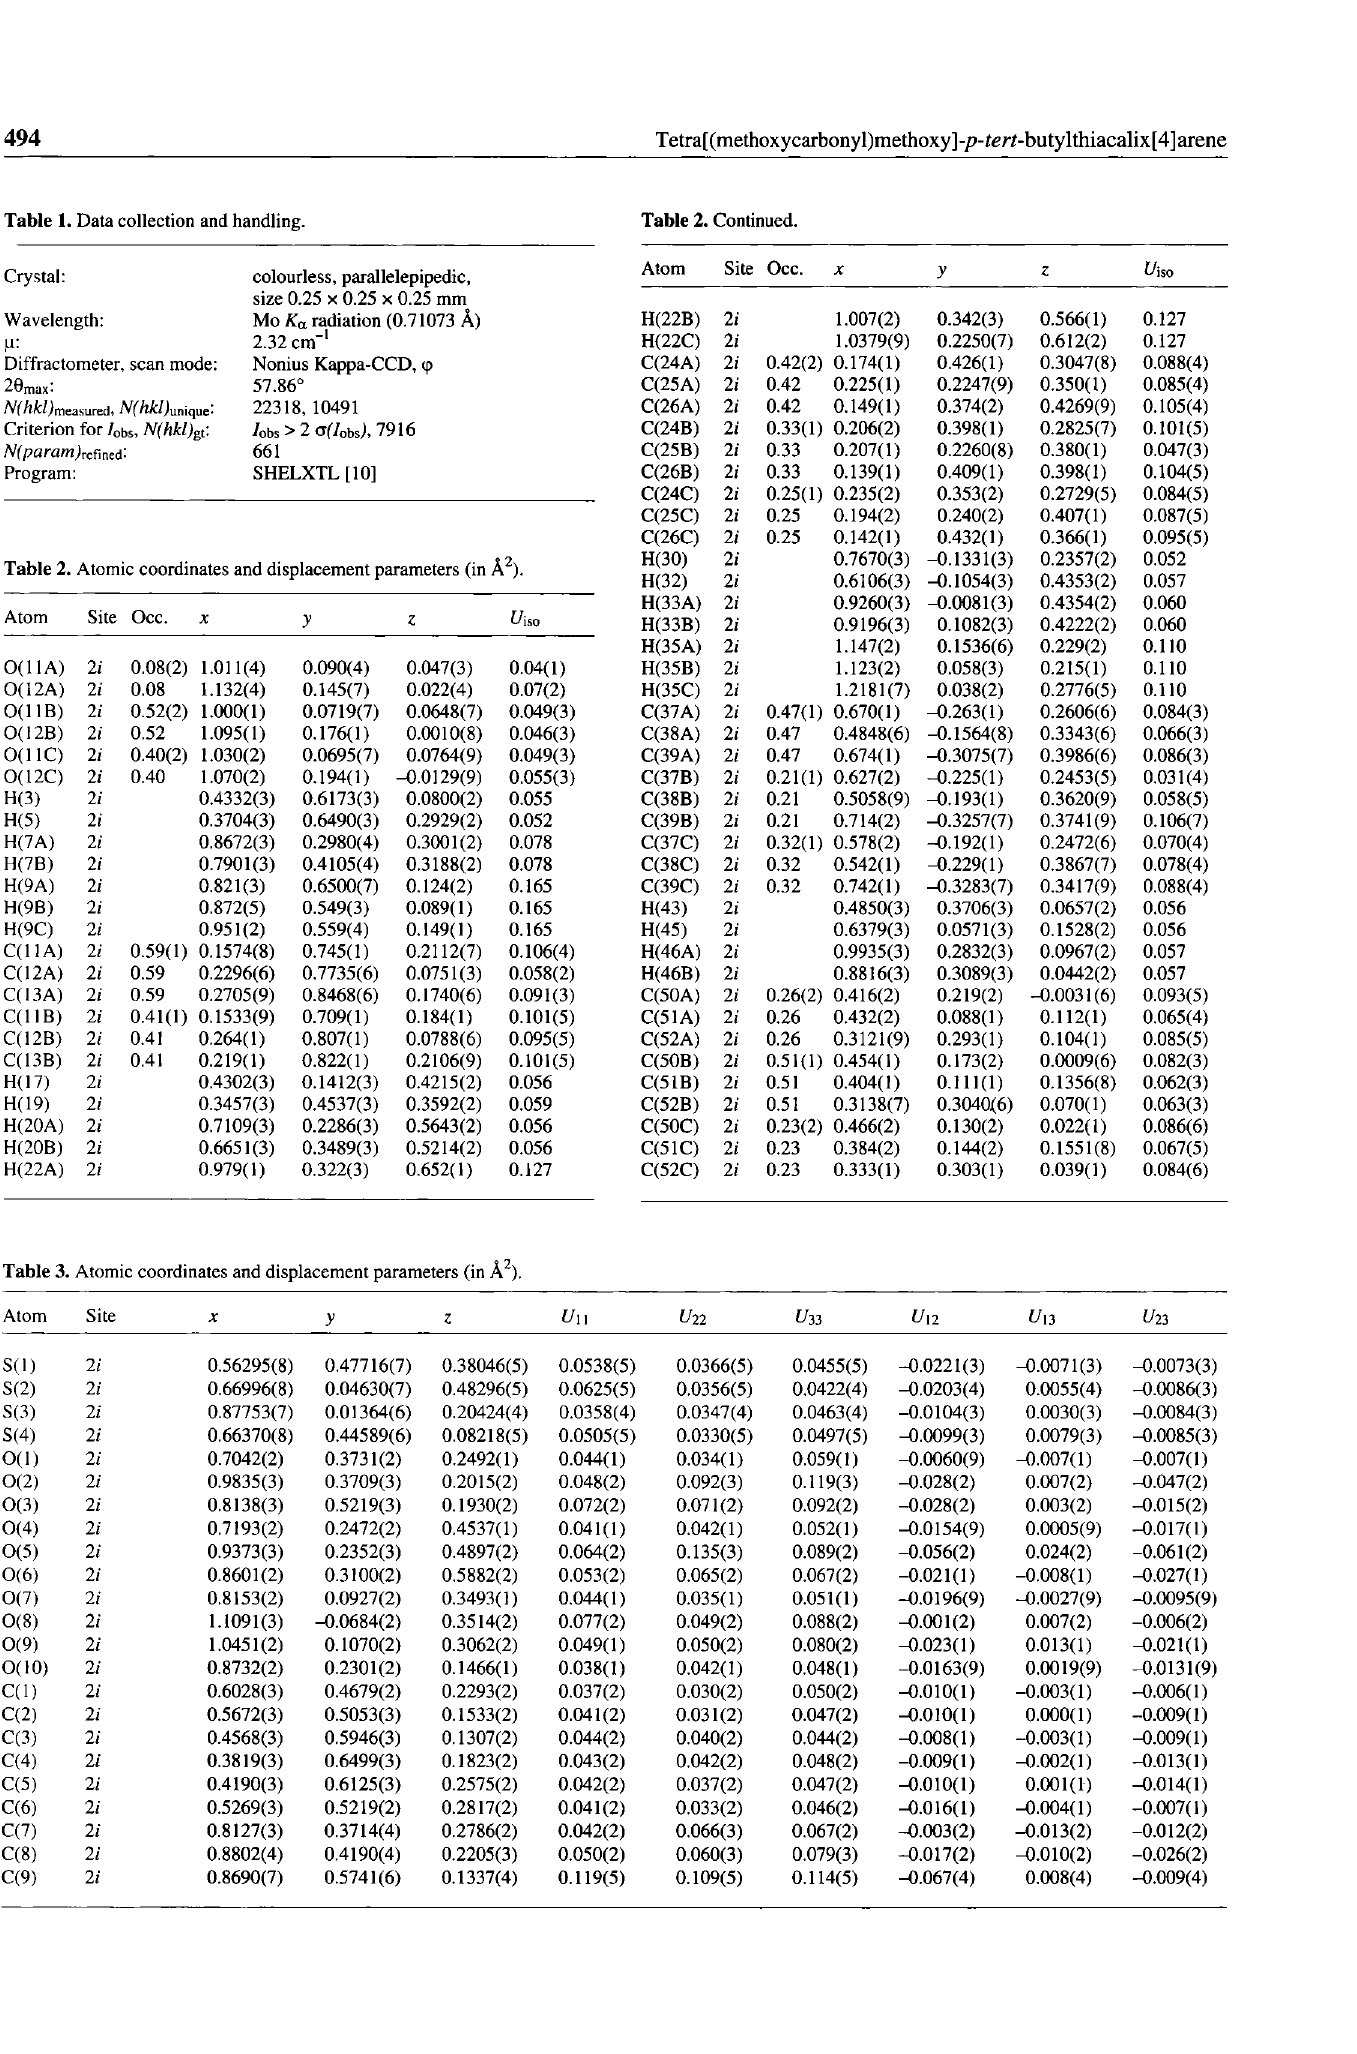
Table 2. Atomic coordinates and displacement parameters (in Â 2 ).